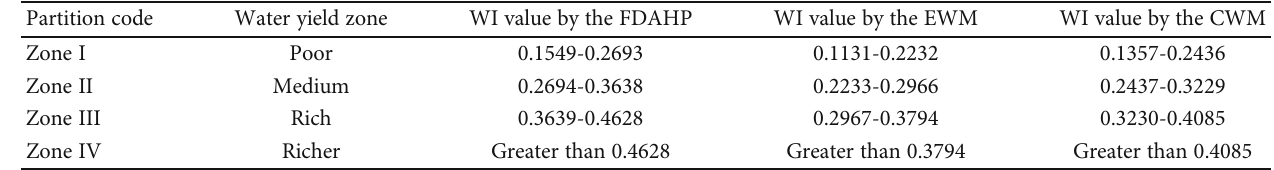
Figure 9: Water yield zoning map based on the IWYPI model weighted by the CWM. Table 6: Classi fi cation thresholds of WI values by the FDAHP, EWM, and CWM.